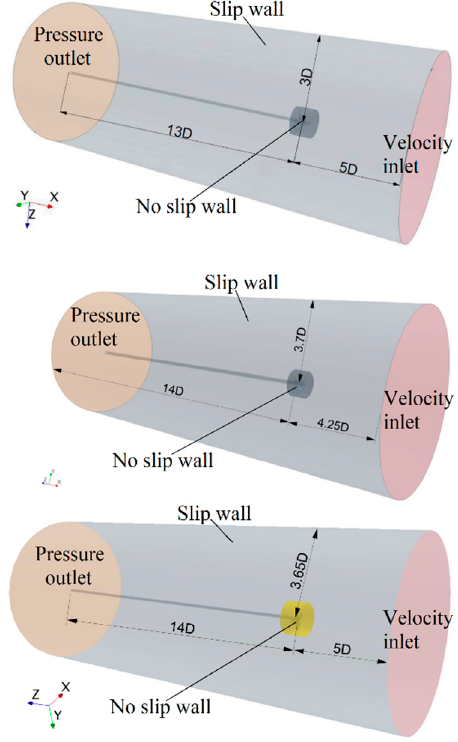
Figure 3. Computational domain for the open water test (OWT): KP505 ( upper ), KP458 ( middle ) and WB ( lower ).